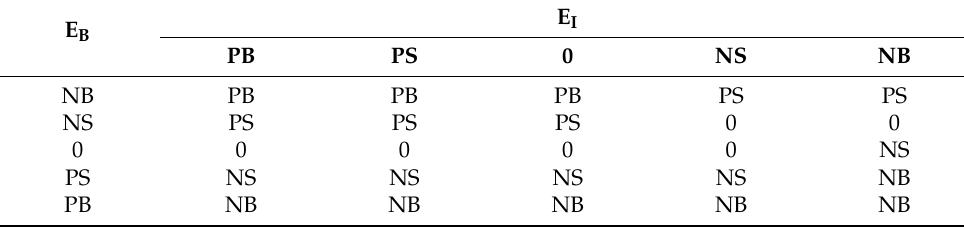
Table 3. Fuzzy rules for dI β q